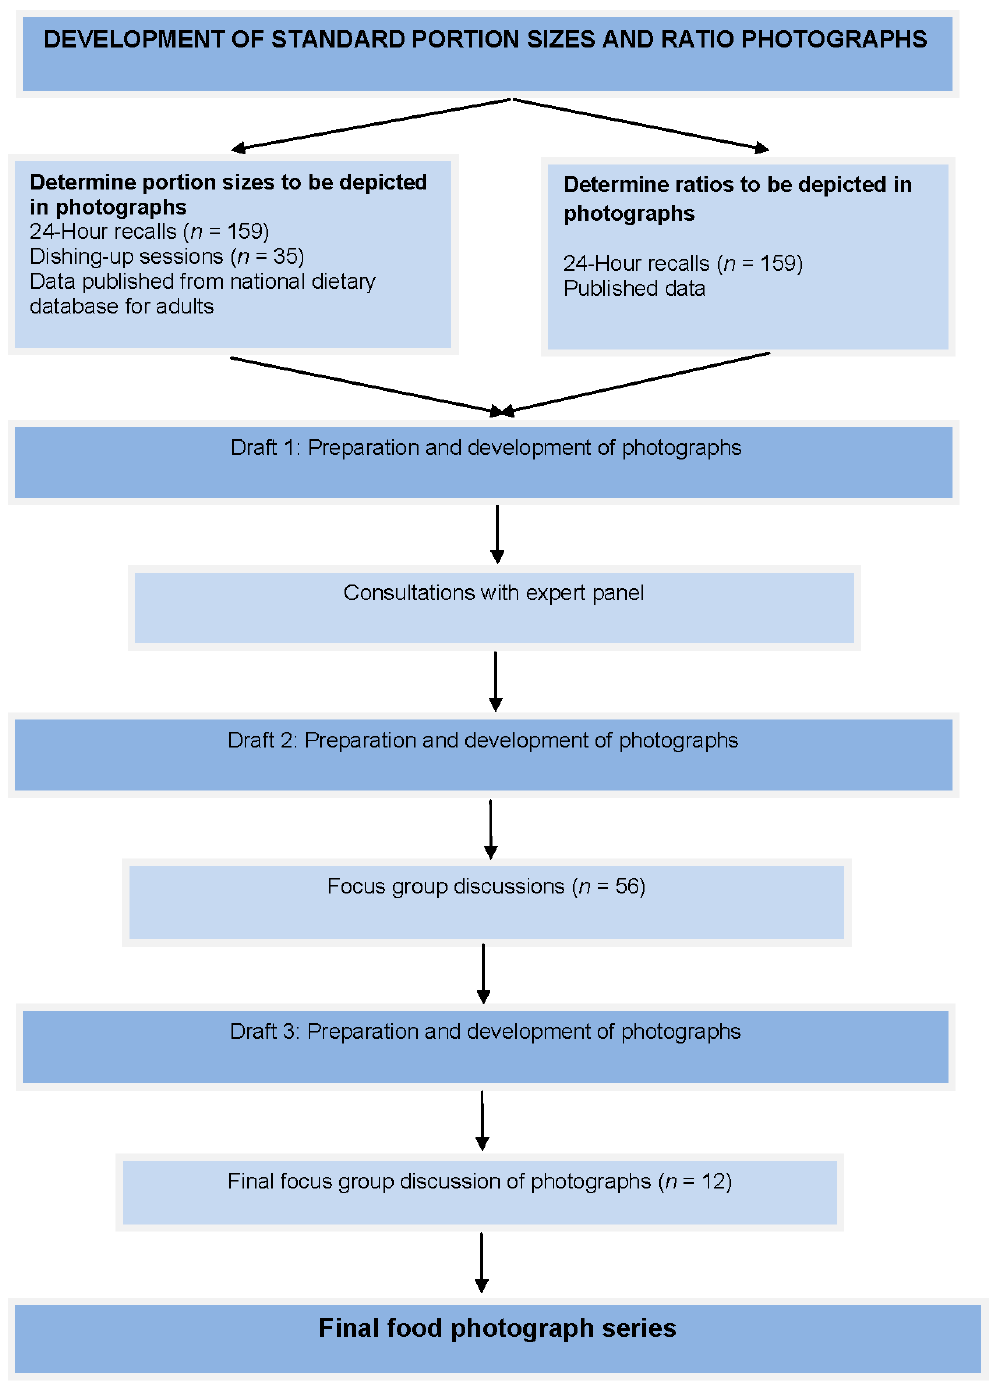
Figure 1. Process followed for the development of the portion size and ratio